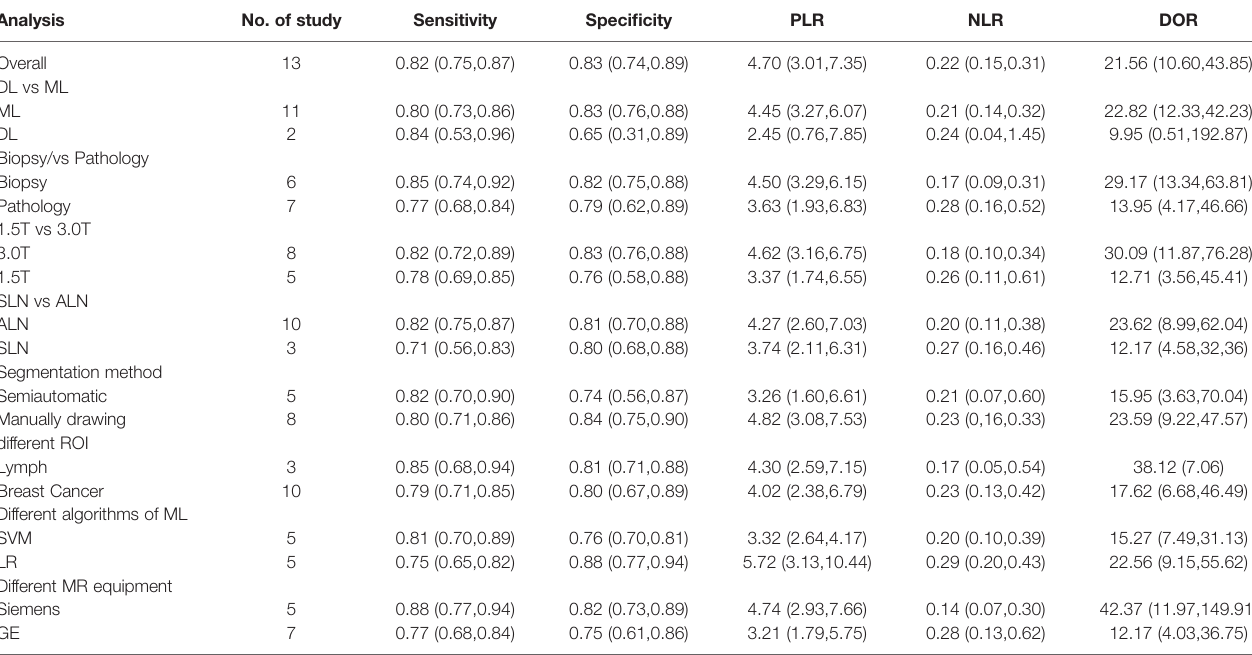
PLR, positive likelihood ratio; NLR, negative likelihood ratio; DOR, diagnostic odds ratio; SVM,support vector machines; LR,logistic